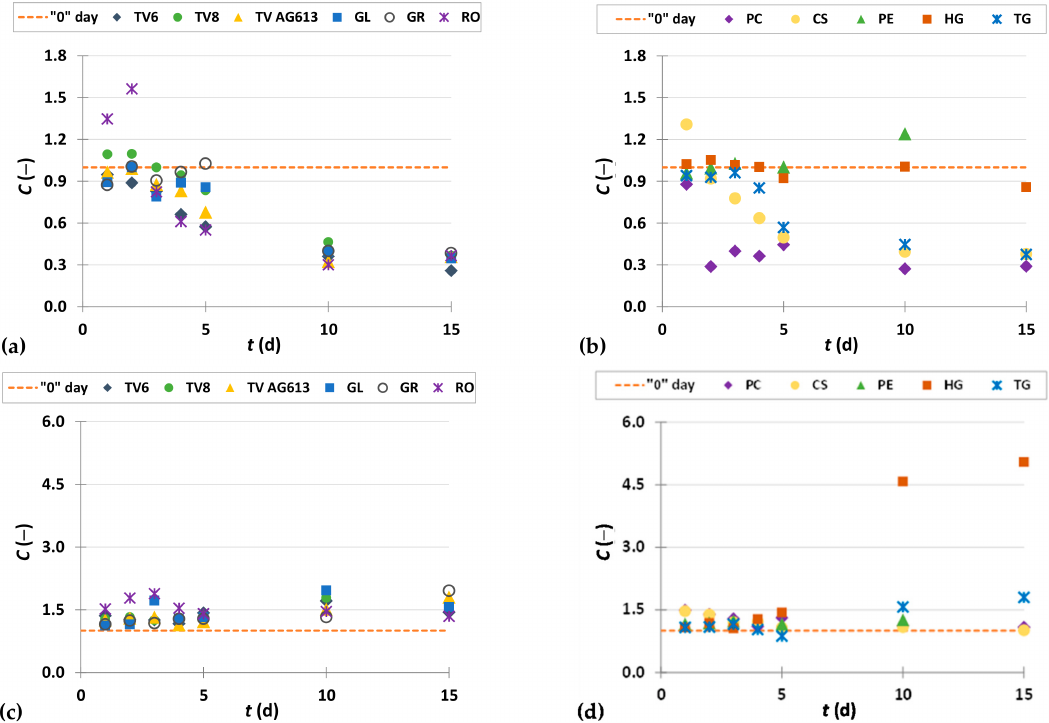
Figure 4. Dimensionless content ( C = C i / C o ) of vanillic acid ( a , b ) and 3,4-dihydroxybenzoic acid ( c , d ) in GP extracts before biological treatment (‘0’ day) and after 1–15 days of biological treatment with TV6, TV8, TV AG613, GL, GR, RO ( a , c ), and PC, CS, PE, HG, TG ( b , d ).